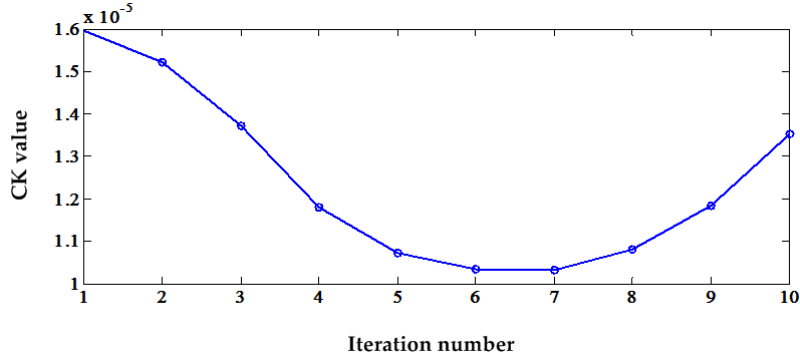
Figure 21. CK value variation vs. iteration number.